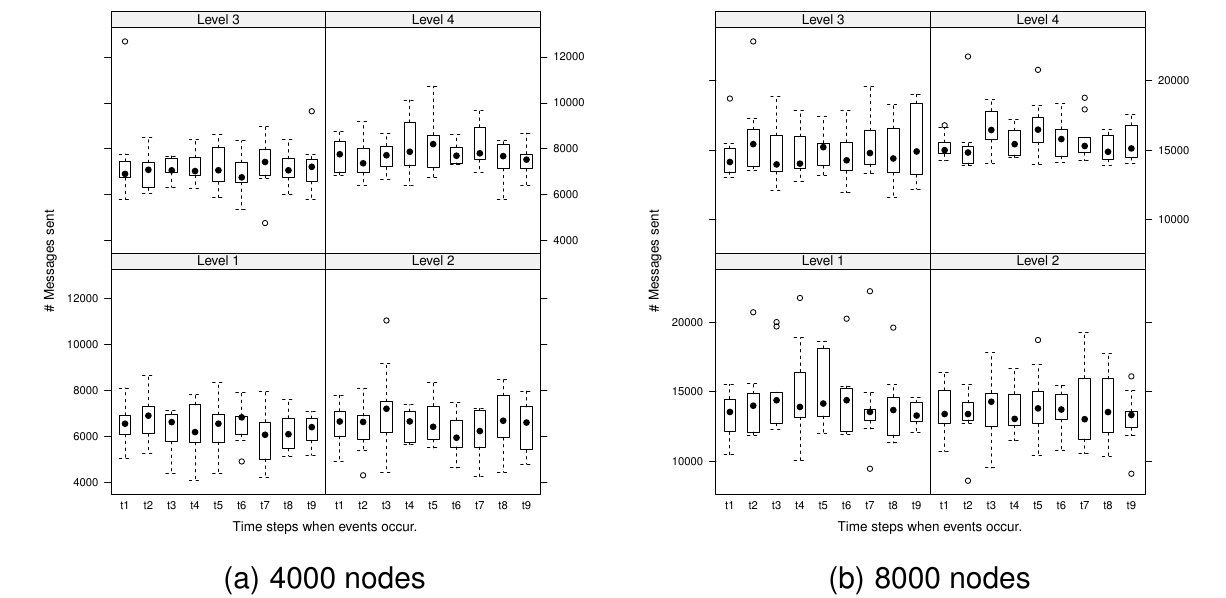
Figure 7. Number of messages generated by spatial events at each evolution step: dots are deemed to be